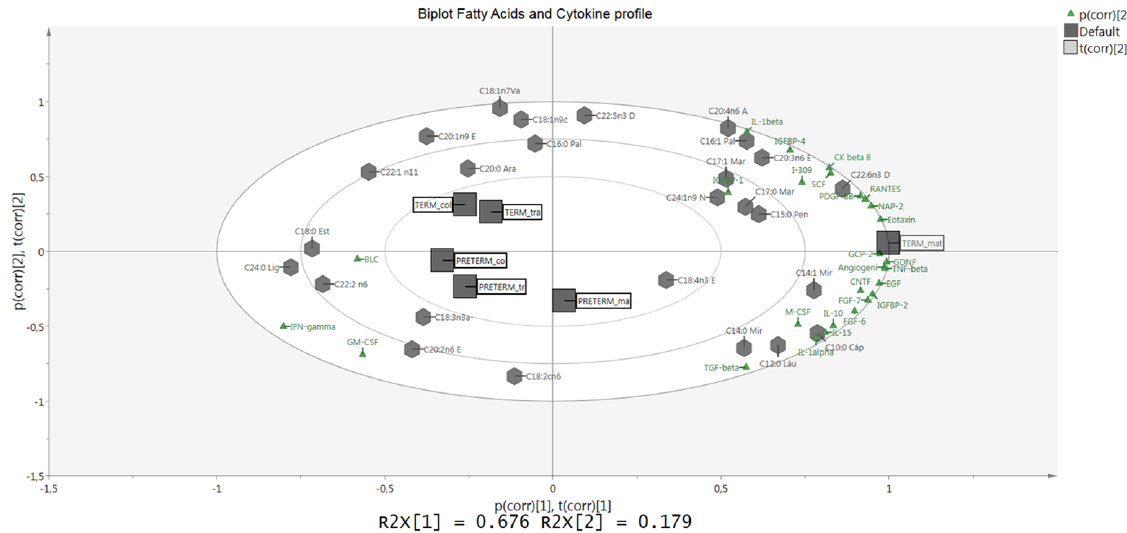
Figure 6. Biplot PCA model representing the correlation structure of the dataset in a two-dimensional space of the fatty acid profile ( n = 40 fatty acids determined) obtained by gas liquid chromatography and cytokine profile ( n = 60 cytokines) obtained by protein arrays from milk samples.